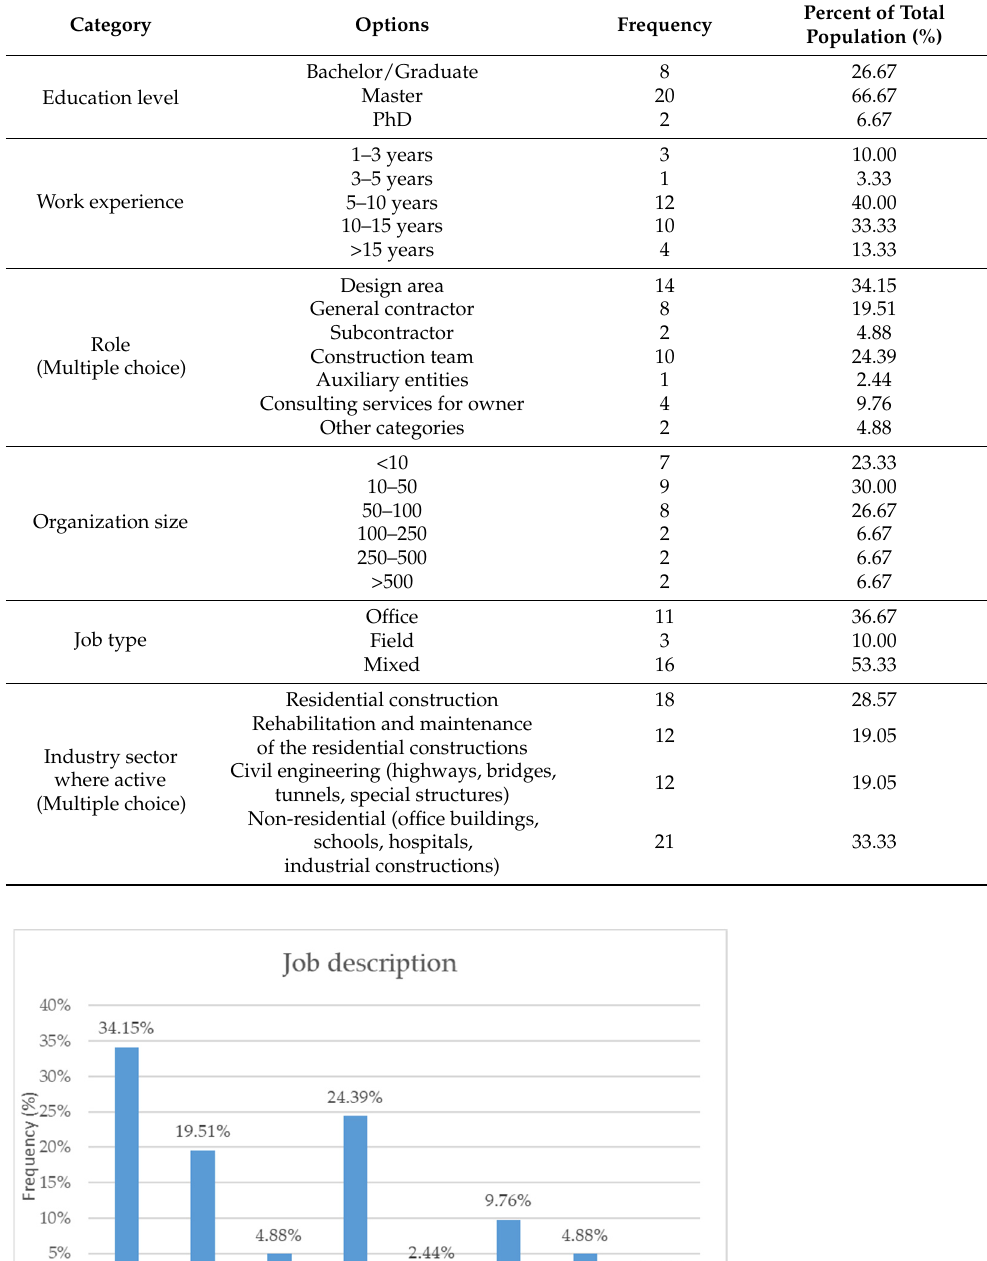
Table 2. Respondents’ profiles.